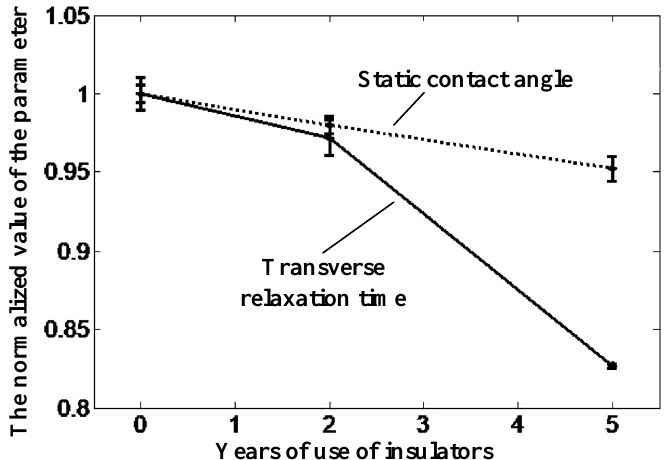
Figure 19. T 2 eff and static contact angle of the Figure 19. T 2eff and static contact angle of the insulators.